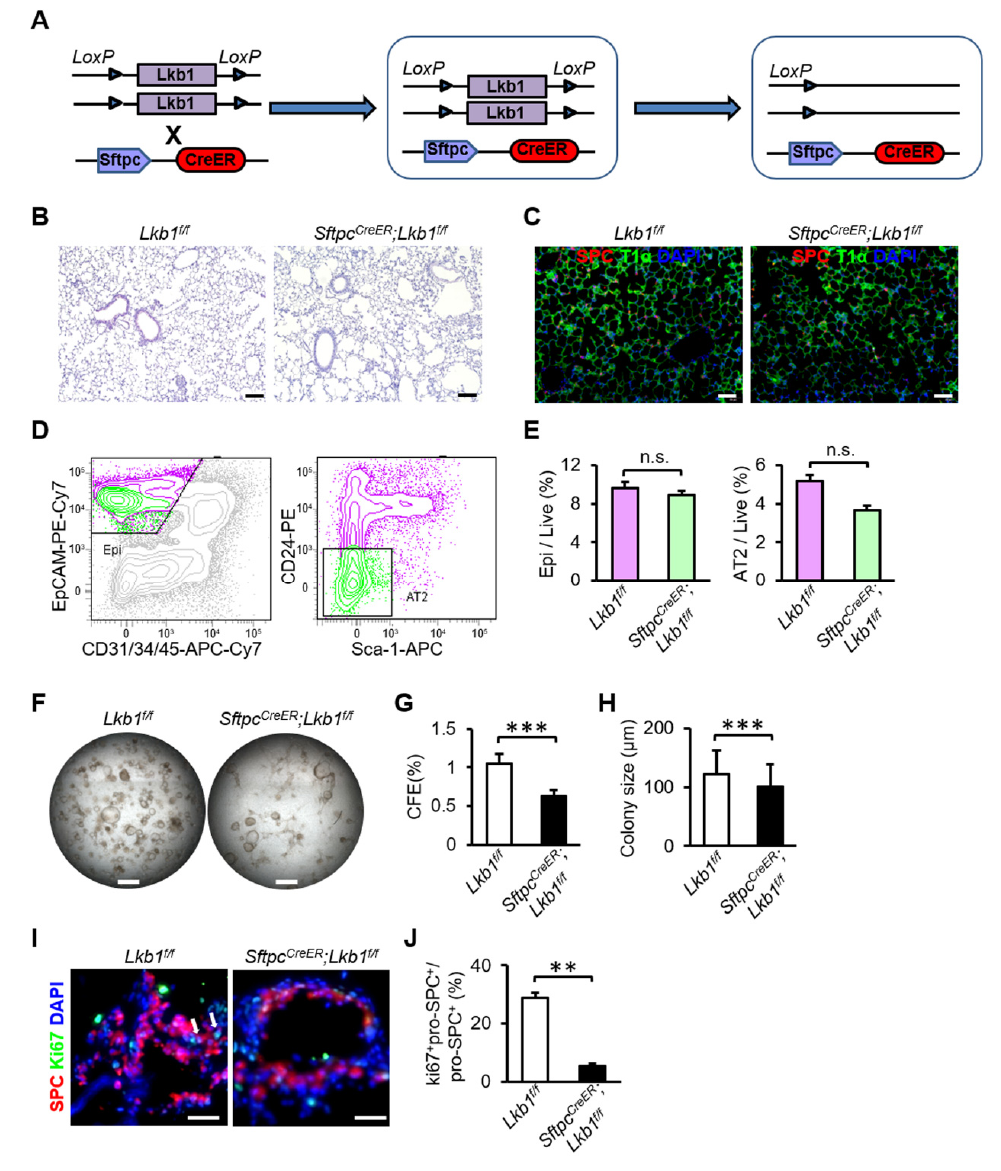
Figure 3. Lkb1 is required for the proliferation of alveolar progenitor cells in vitro. ( A ) Schematic of Sftpc CreER ; Lkb1 f/f mice. ( B ) Hematoxylin and eosin staining of lung tissues from Lkb1 f/f mice and Sftpc CreER ; Lkb1 f/f mice (Scale bars, 100 µ m). ( C ) Immunostaining of lung tissues for SPC (AT2)